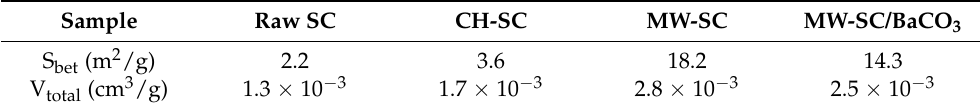
Figure 5. SEM micrographs of ( a ) raw SC; ( b ) SC after CO 2 gasification in conventional heating (CH); ( c ) SC after CO 2 gasification in a microwave (MW); ( d ) SC/BaCO 3 after CO 2 gasification in a MW. Reaction conditions: the SC particle size was 0.200–0.450 mm and the reaction temperature was 750 °C. Table 1. The calculations of specific surface area (BET), and total pore volume. Sample Raw SC